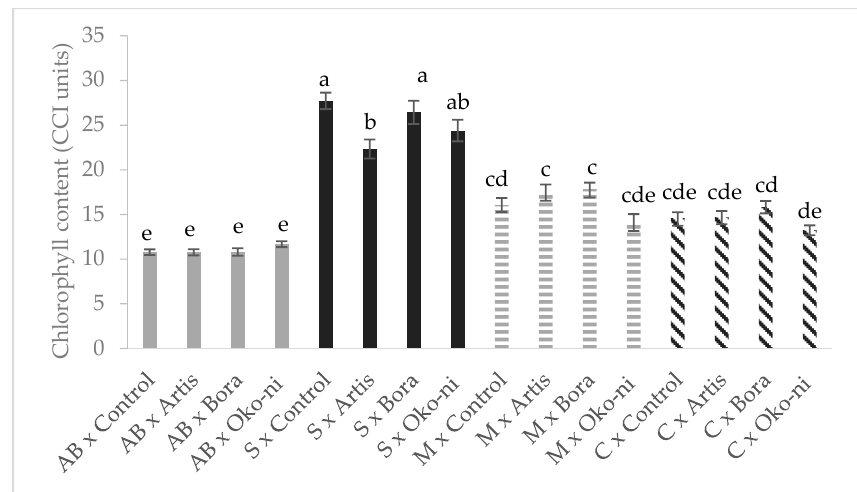
Figure 2. Interaction effects of cultivar and myco-biocontrol formulate on essential oil content of basil. Values with the same lower-case letters are not statistically different at p < 0.05 according to